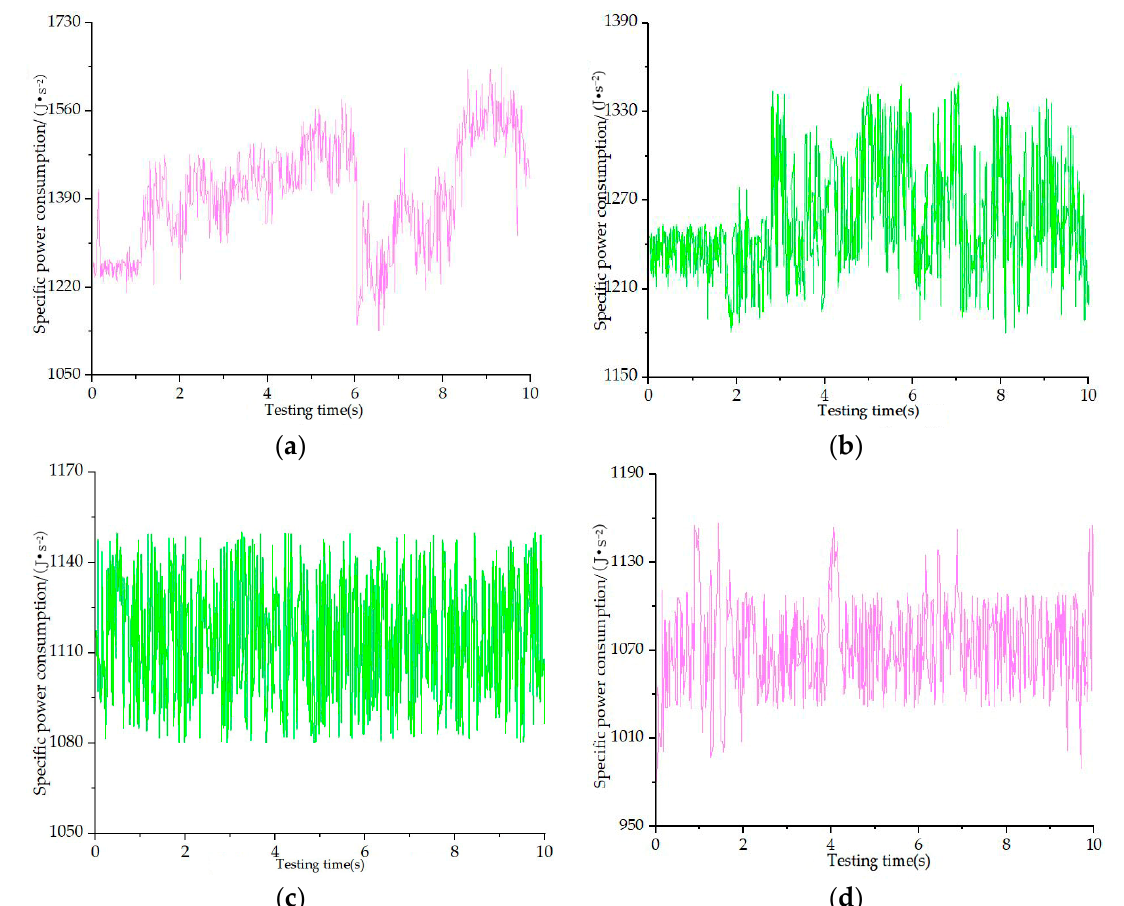
Figure 11. ( a ) Changes of specific power consumption at F3M1 level; ( b ) Changes of specific power consumption at F3M2 level; ( c ) Changes of specific power consumption at F3M3 level; ( d ) Changes of specific power consumption at F3M4 level.